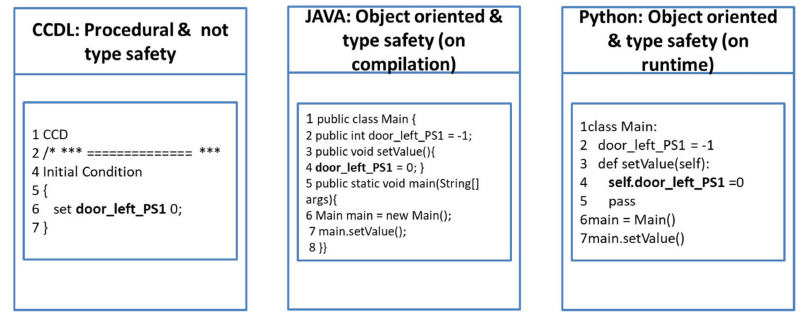
Figure 3. A similar test case in different test cases